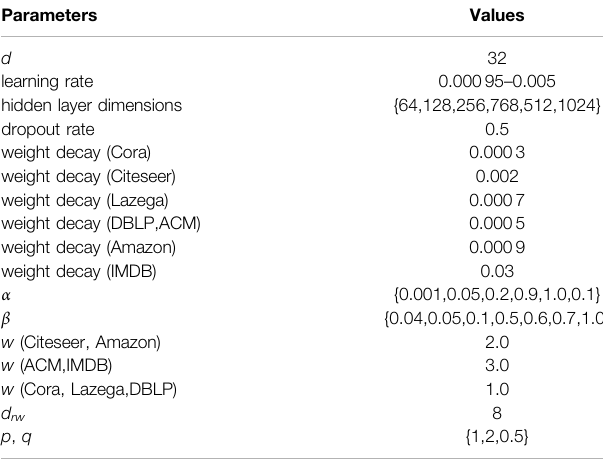
TABLE 3 | The values of